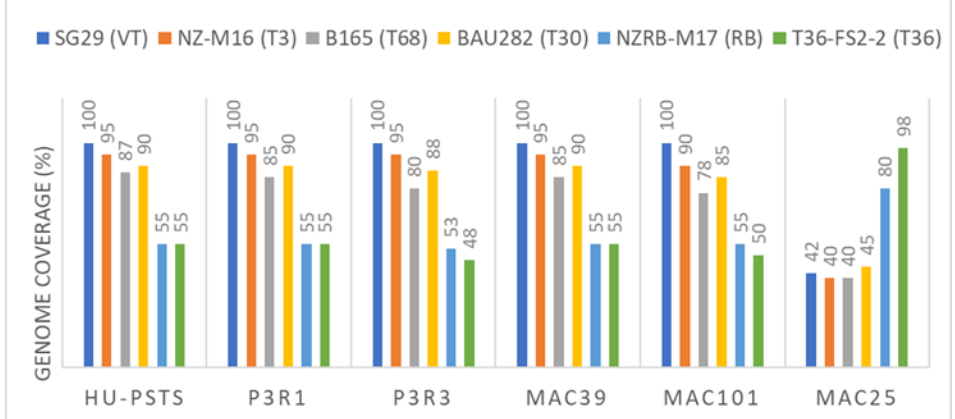
Figure 2. Graphical illustration of genome coverage per representative genome reference of six citrus tristeza virus genotypes after read mapping the siRNA library of each sample individually.